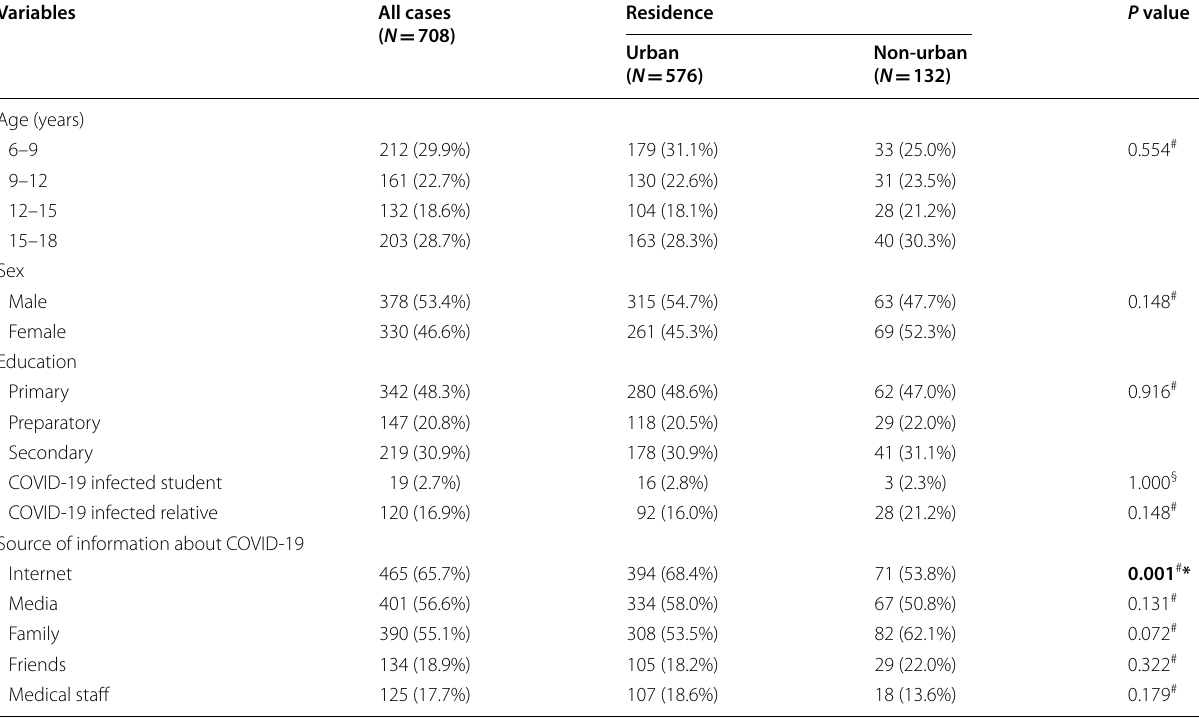
Table 1 Descriptive statistics among the studied cases and according to